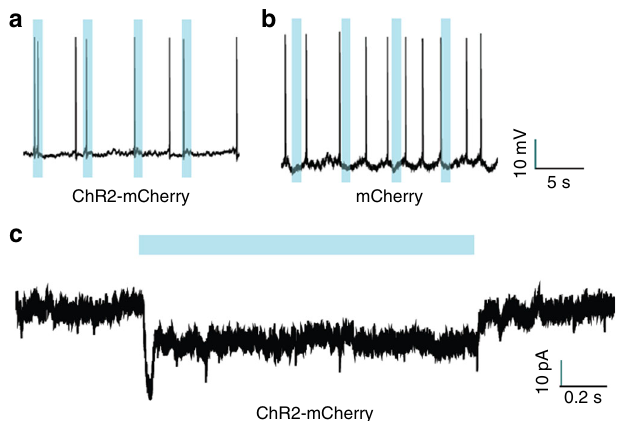
Fig. 3 Stimulation of ChR2-mCherry induces neuronal activity. a , b Representative whole-cell current clamp recordings of neurons expressing ChR2-mCherry ( a ) or mCherry ( b ). c Representative whole-cell voltage clamp recording of neuron expressing ChR2-mCherry. Blue: 473 nm light